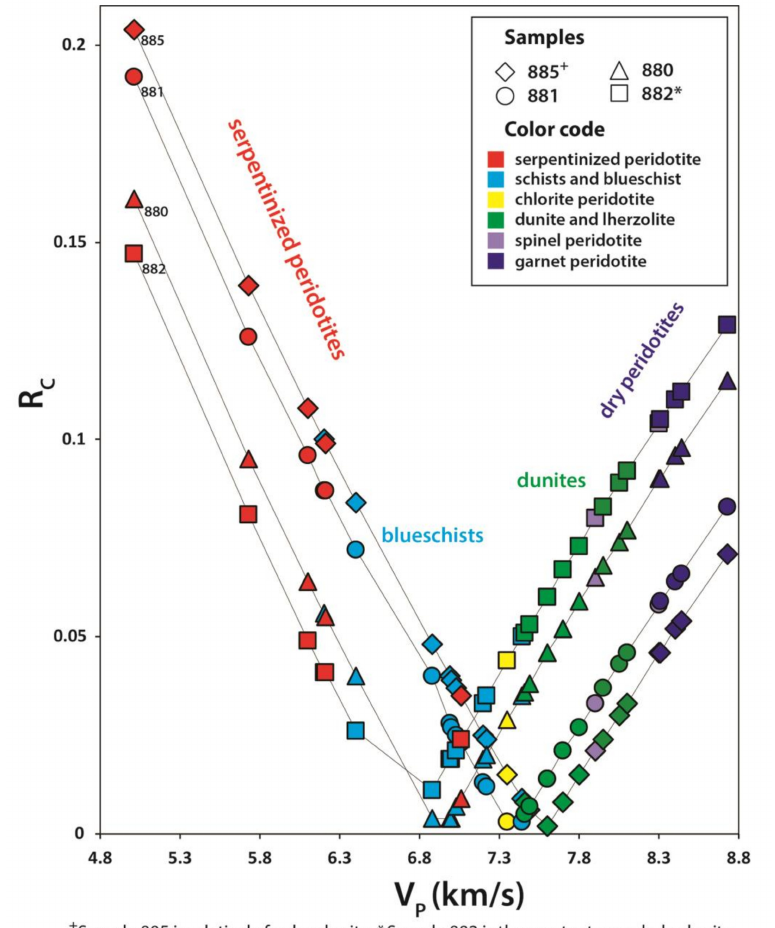
Figure 11. Relationship between P-wave velocity (V P ) of a surrounding rock and reflection coeffi- cient (R C ) of the contact boundary between the studied retrograded eclogite and the surrounding rock (Table